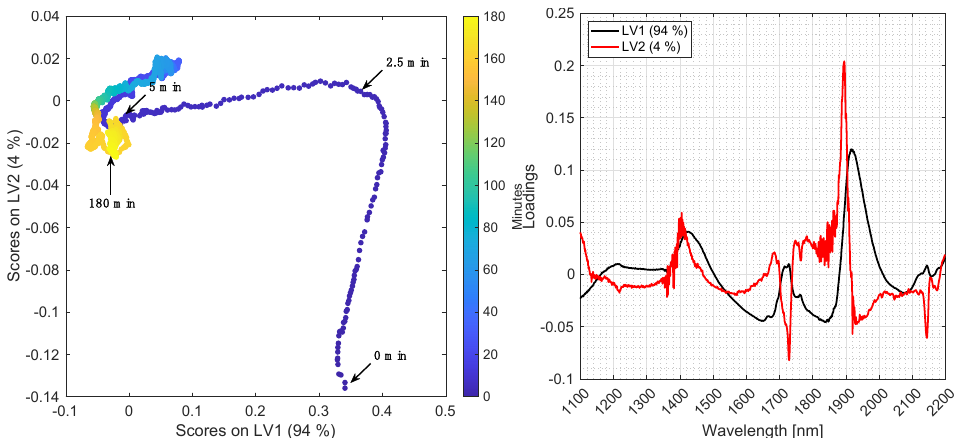
Figure 5. Left: PCA score plot of batch A using EMSC preprocessing and a measurement time window width of 60 s. Right: Loadings plot of LV1 and LV2.